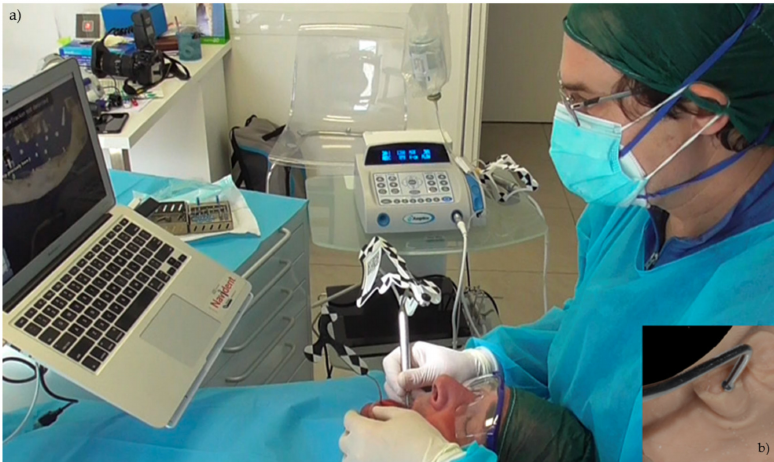
Figure 3. The picture shows the surgeon and the laptop screen where the tracing process is visible ( a ); in the right corner ( b ) the ball tip of the tracer.